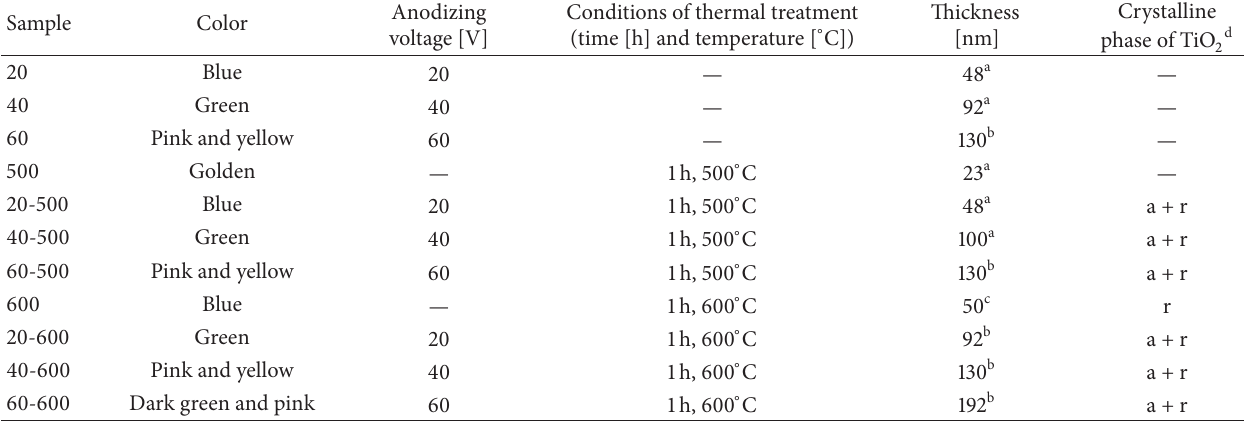
Table 1: Conditions under which the different samples, thicknesses, and detected crystalline phases were obtained.